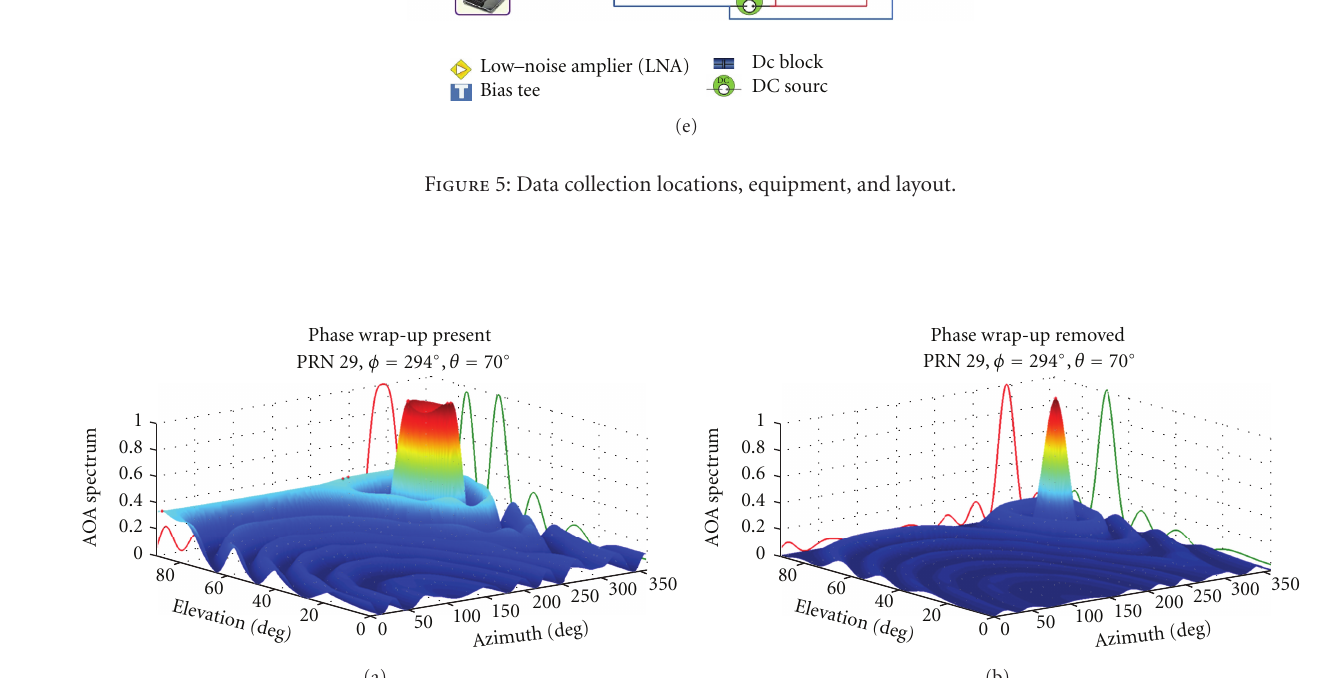
Figure 6: (a) AoA spectrum a ff ected by phase wrap-up. (b) AoA spectrum after removing phase